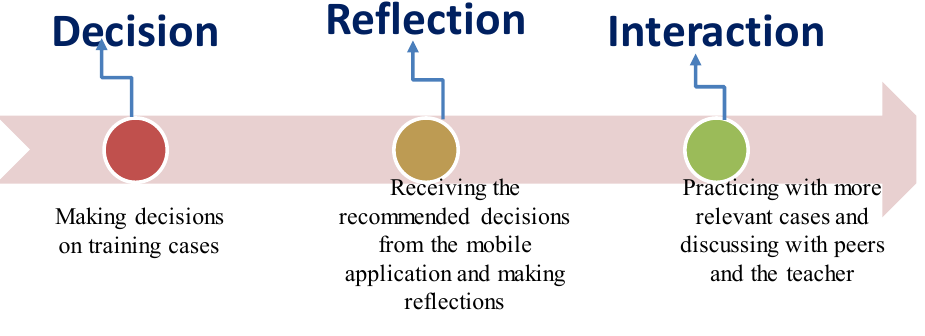
Figure 1. The DRI-based professional training model.